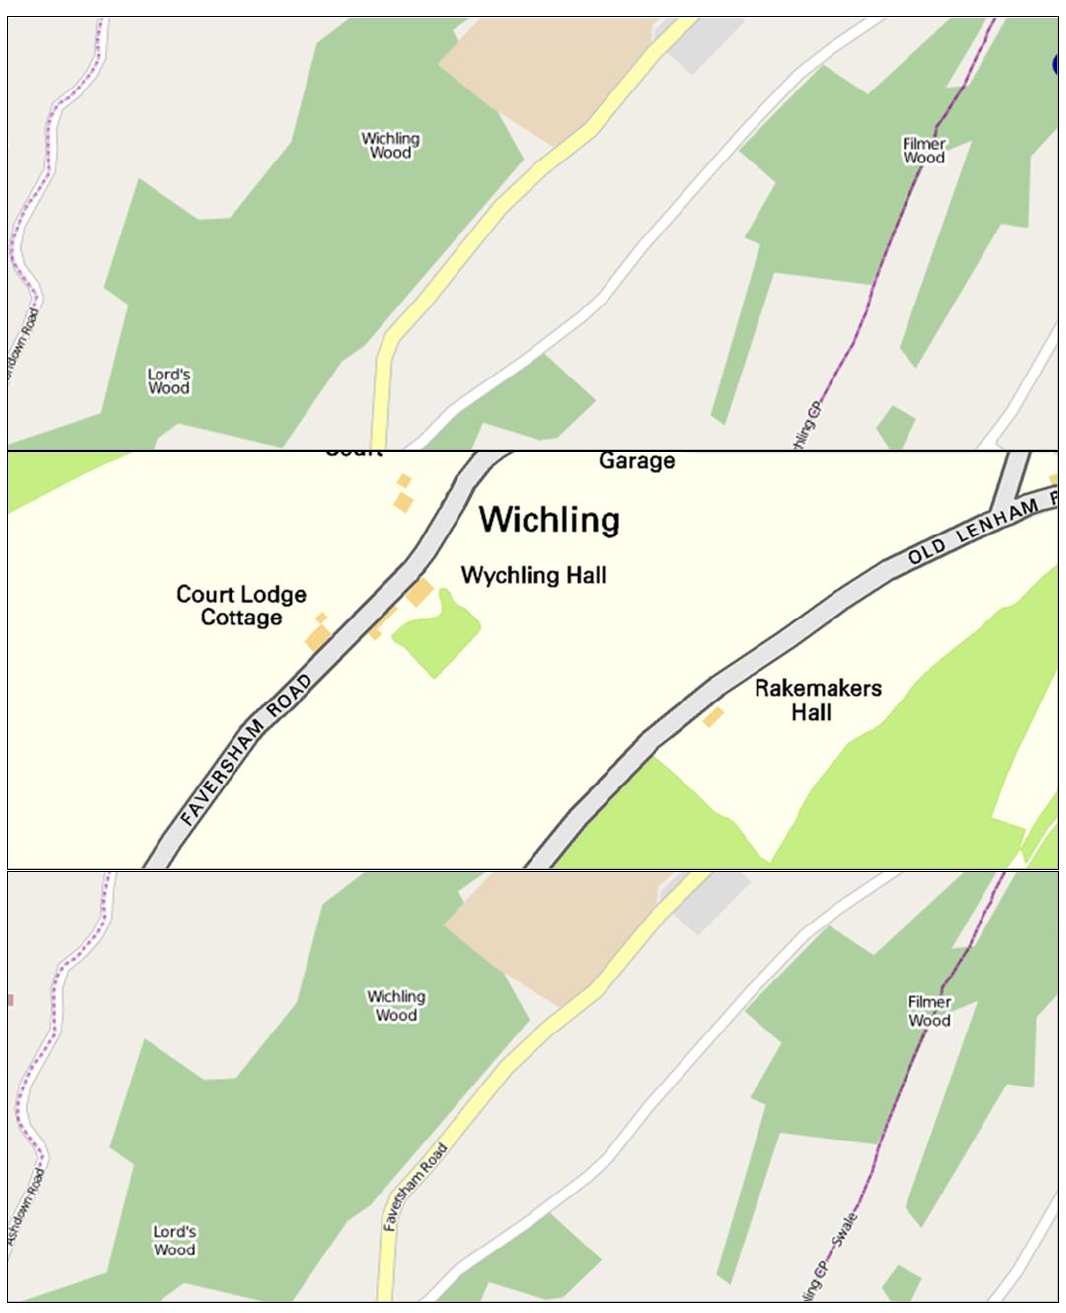
Figure 6. A sample of added road names (Faversham Road, near Ashford). ( Top ): original OSM; ( Middle ): OS Open Data map of the same area; ( Below ): updated in